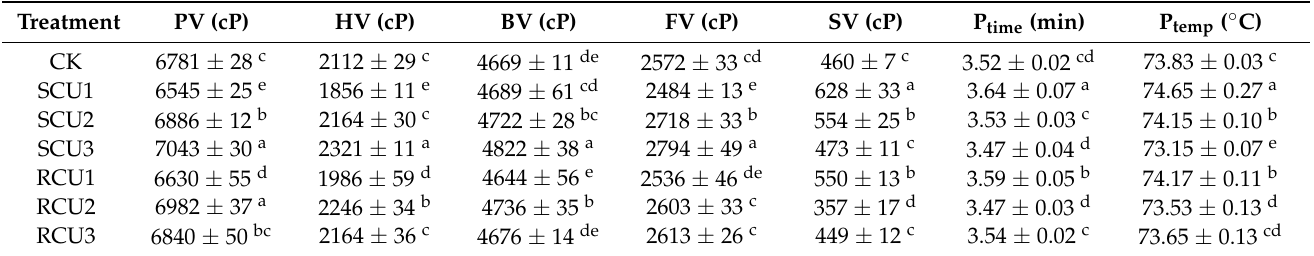
Table 3. Effects of SCU and RCU on starch pasting properties in the rhizomes of the